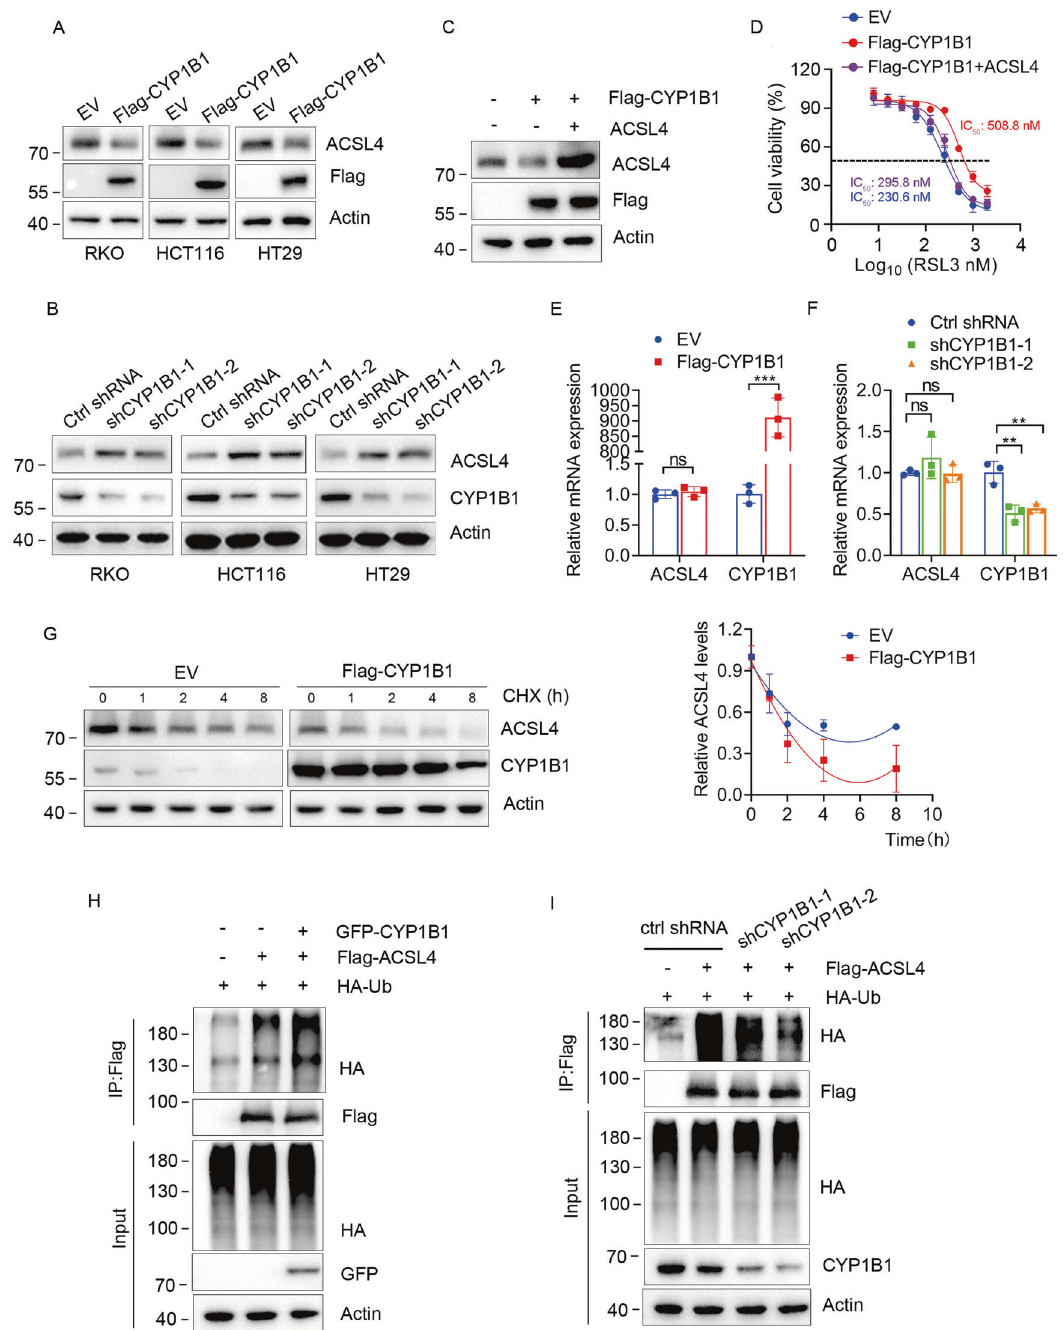
Fig. 2 CYP1B1 regulates ferroptosis by mediating ACSL4. A , B RKO, HCT116 and HT29 cells with CYP1B1 overexpression or knockdown via lentiviral infection, followed by western blot using the indicated antibodies. C Western blot analysis of RKO cells were transfected with empty vector (EV) or ACSL4 plasmids. D Viability curves of RKO cells treated with indicated RSL3 concentrations. E , F The mRNA levels of RKO cells with CYP1B1 overexpression or knockdown were analyzed using qPCR. The data shown represents the mean ± SD. n = 3. p value was determined by student ’ s two-sided t test. ** p < 0.01, *** p < 0.001. G RKO cells expressing EV or Flag - CYP1B1 were treated with 100 μ g/ml CHX and harvested at the indicated times. Cells were lysed and analyzed using western blot with the indicated antibodies (left). Quanti fi cation of ACSL4 protein levels was shown (right). The data shown represent the mean ± SD. n = 3. H RKO cells were transfected with Flag-ACSL4, GFP- CYP1B1 and HA-Ub, after 48 h, treated with 5 μ M MG132 for 6 h, then analyzed for ACSL4 ubiquitination. I CYP1B1 ctrl or knockdown RKO cells were transfected with Flag-ACSL4 and HA-Ub for 48 h and treated with 5 μ M MG132 for 6 h before harvesting for ubiquitination analysis. not rescue ACSL4 expression in CYP1B1 overexpressed cells, and acids (HETEs) [13]. Therefore, we questioned whether CYP1B1 ACSL4 expression appeared reduced (Fig. 3A). According to this reduced ACSL4 protein level by downregulating intracellular AA. result, we speculated that CYP1B1 may protect cells from RKO cells were transfected with EV or Flag-CYP1B1 plasmids and ferroptosis by degrading ACSL4 via metabolites of AA. The treated with 10 μ M AA for 24 h. Western blot showed that AA did